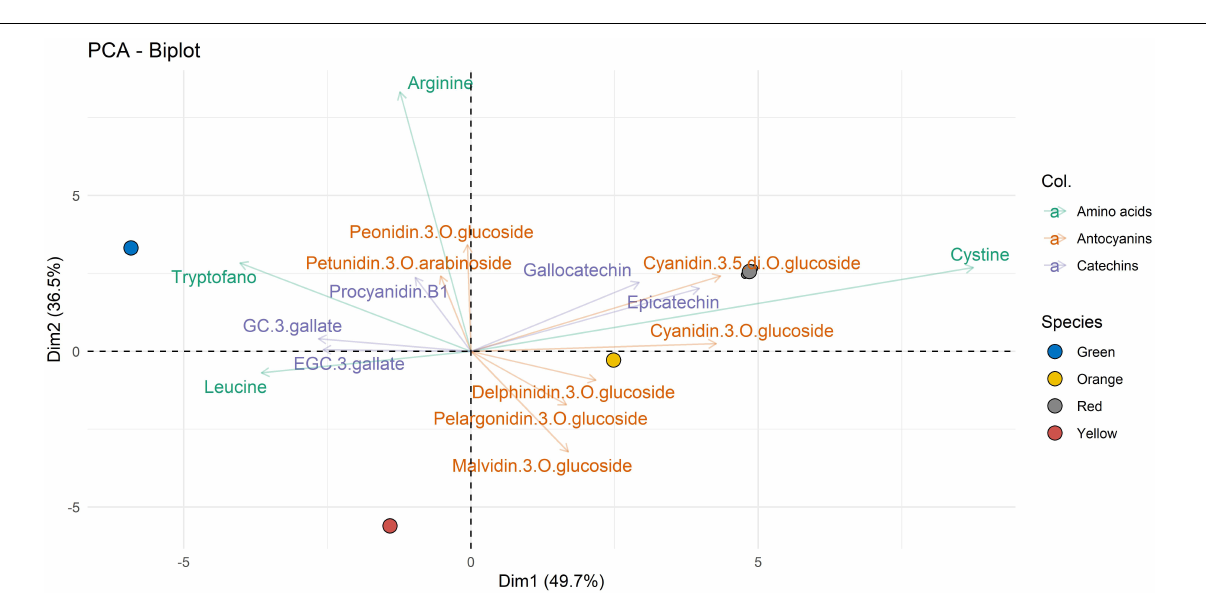
FIGURE 3 | Two-dimensional principal component analysis (PCA) biplot showing associations between experimental samples ( A. unedo fruit) and compounds abundance (clr-transformed data). Original data are summarized in Table 6 and in Supplementary Table 1 . Compounds extracted in H1 are represented. Samples are shown according to the ripening stages (green, yellow, orange, and red) and compounds are shown according to polyphenol